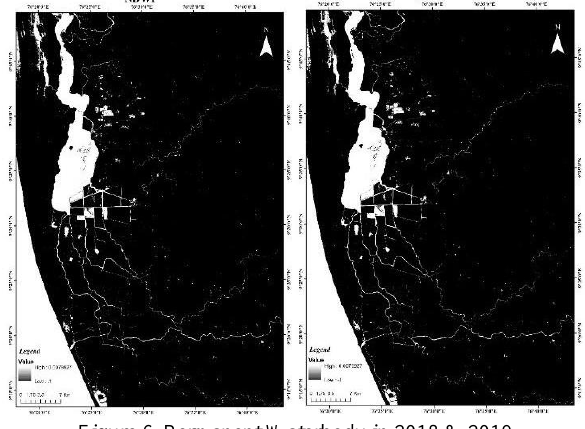
Figure 6. Permanent Waterbody in 2018 & 2019 Land, agricultural areas has a low reflectance of (-1) value and the water body has a high reflectance of (0.079) in 2018 February10 before the flood event, here Vembanad lake is delineate as a